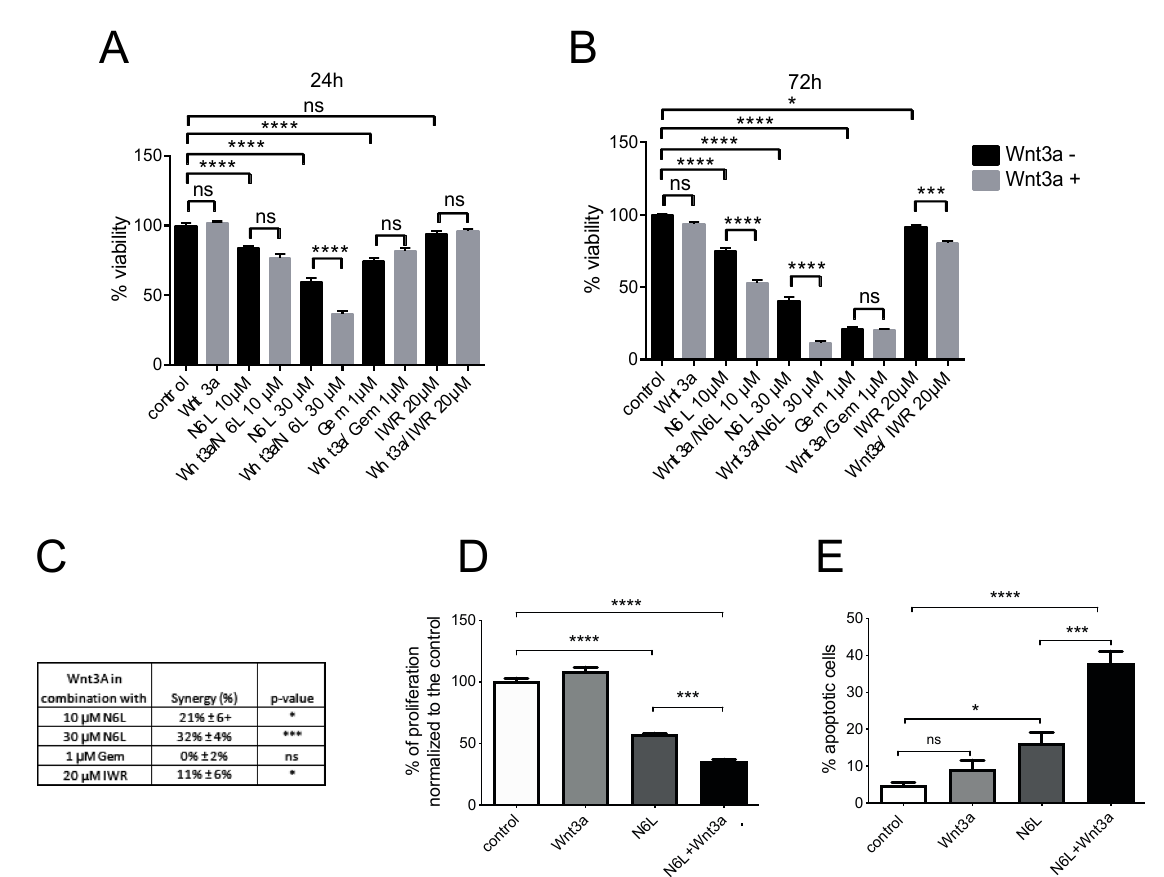
Figure 4. Wnt/ β -catenin pathway activation specifically sensitizes cells to N6L targeting. ( A , B ) MIA PaCa-2 cells were treated for 24 and 72 h with 10 µ M and 30 µ M N6L, 1 µ M gemcitabine or 20 µ M IWR-1-endo in presence or absence of Wnt3a-CM. Control cells were stimulated or not with Wnt3a-CM. Cell viability was analyzed as described in Materials and Methods. (One-way ANOVA, multiple comparison, n = 4 experiments, ns = non-significant, * p < 0.05, *** p < 0.005, **** p < 0.001). ( C ) The synergy of the different combinations of treatments together with Wnt3a has been calculated by using the software Combenefit described in Materials and Methods. The score of synergy and the p -value are indicated in the table. ( D ) The effect of treatments on cell proliferation were evaluated by analayzing a cell tracer amount after 72 h and the graph indicates cell proliferation versus control cells. ( E ) After 24 h of treatment, apoptosis was evaluated by Annexin V staining and the graph indicates the % of apoptotic cells. (One-way ANOVA, multiple comparison, n = 4 experiments in ( A , B ), n = 3 experiments in ( D , E) , ns = non-significant, * p < 0.05, *** p < 0.005, **** p < 0.001).